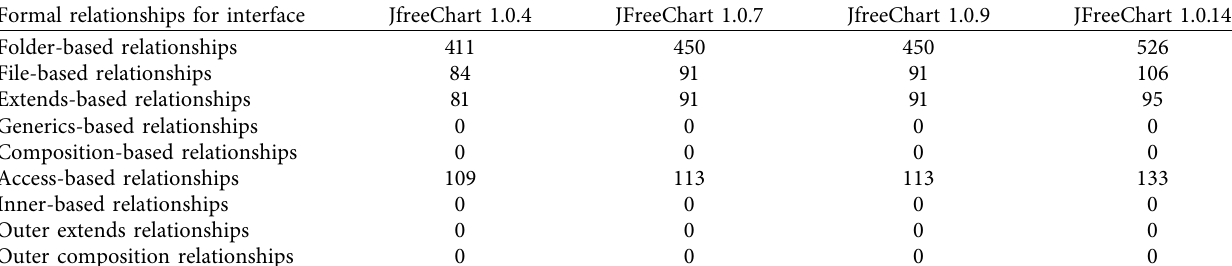
Table 14: Formal relationships for interface in JFreeChart.